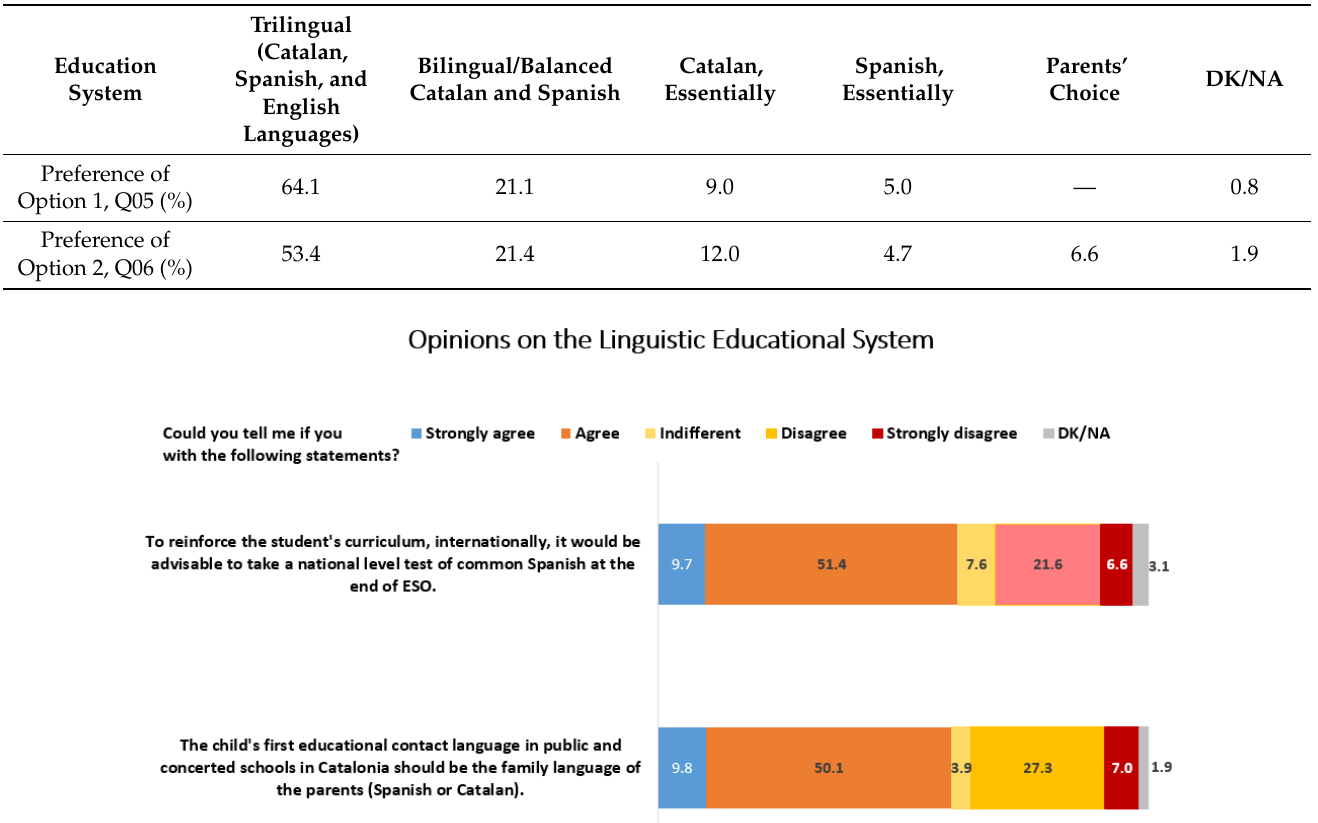
Table 1. Preferences regarding the linguistic educational system at school. The table displays preferences regarding the language system used at schools for the entire sample (questions Q05 and Q06). The answer “basically in Catalan” as an answer to Q06 is abbreviated; the exact survey answer is “all in Catalan, except for a Spanish Language course and in one or two core subjects”. The same applies to the answer “ basically in Spanish ”, exchanging Catalan for Spanish. None of these answers apply to the current educational language policy, which reduces the time spent on the Spanish language in secondary education to two or three hours per week.